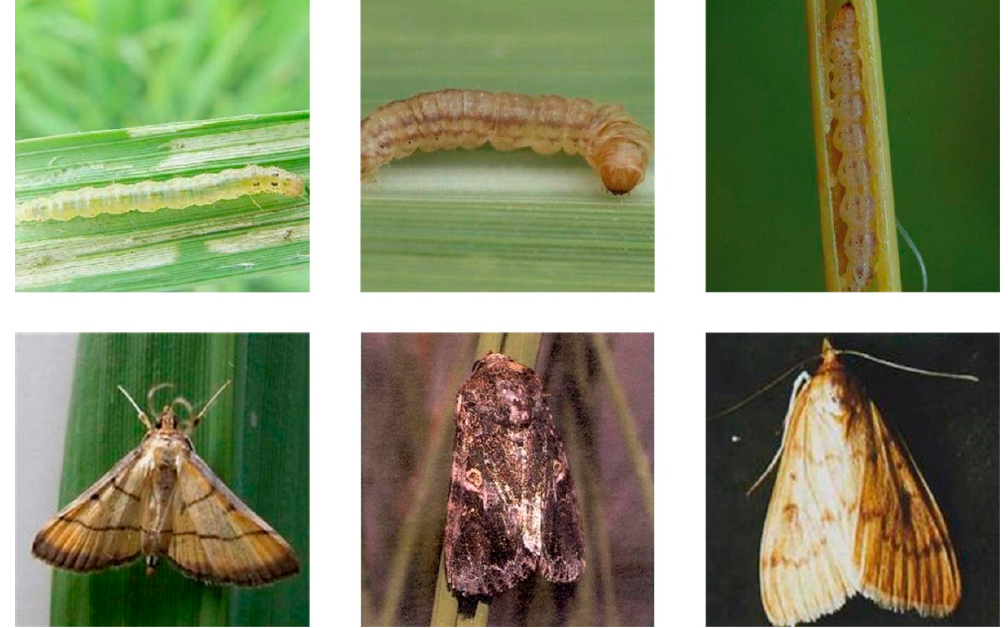
Figure 4. Sample of IP102 dataset images. Line 1 shows three different caterpillar species and Line 2 shows three different moth species; columns 1, 2 and 3 show the morphology of the same pest in different life cycles.